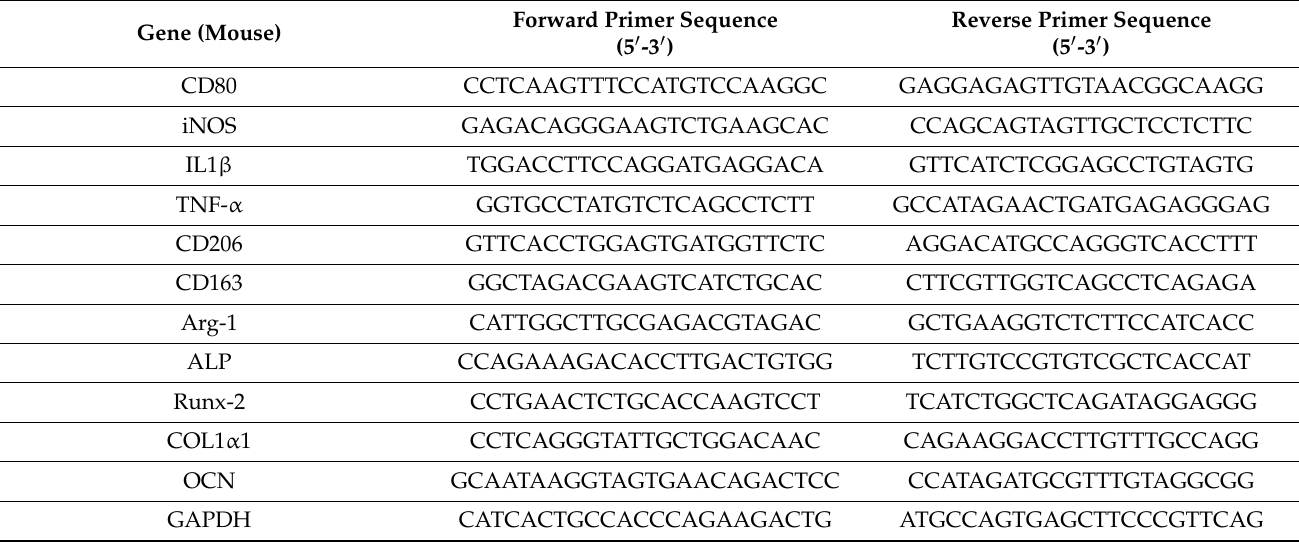
Table 2. Primers and sequences used for qPCR in this